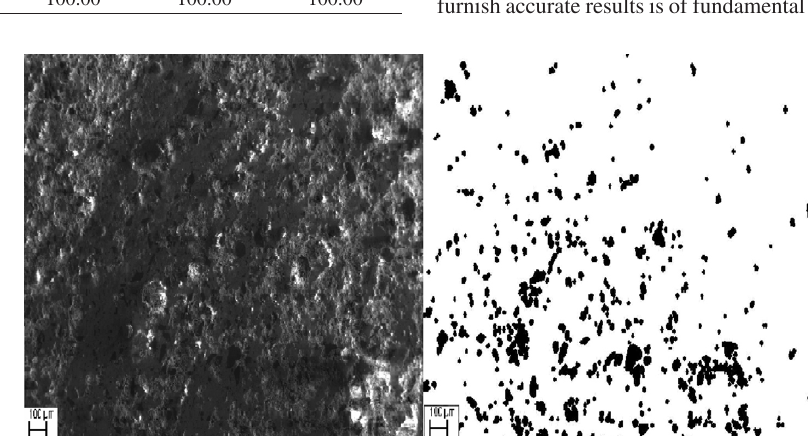
Figure 3. Selection of the pixels for the porosity identification in a random area of 2D image.